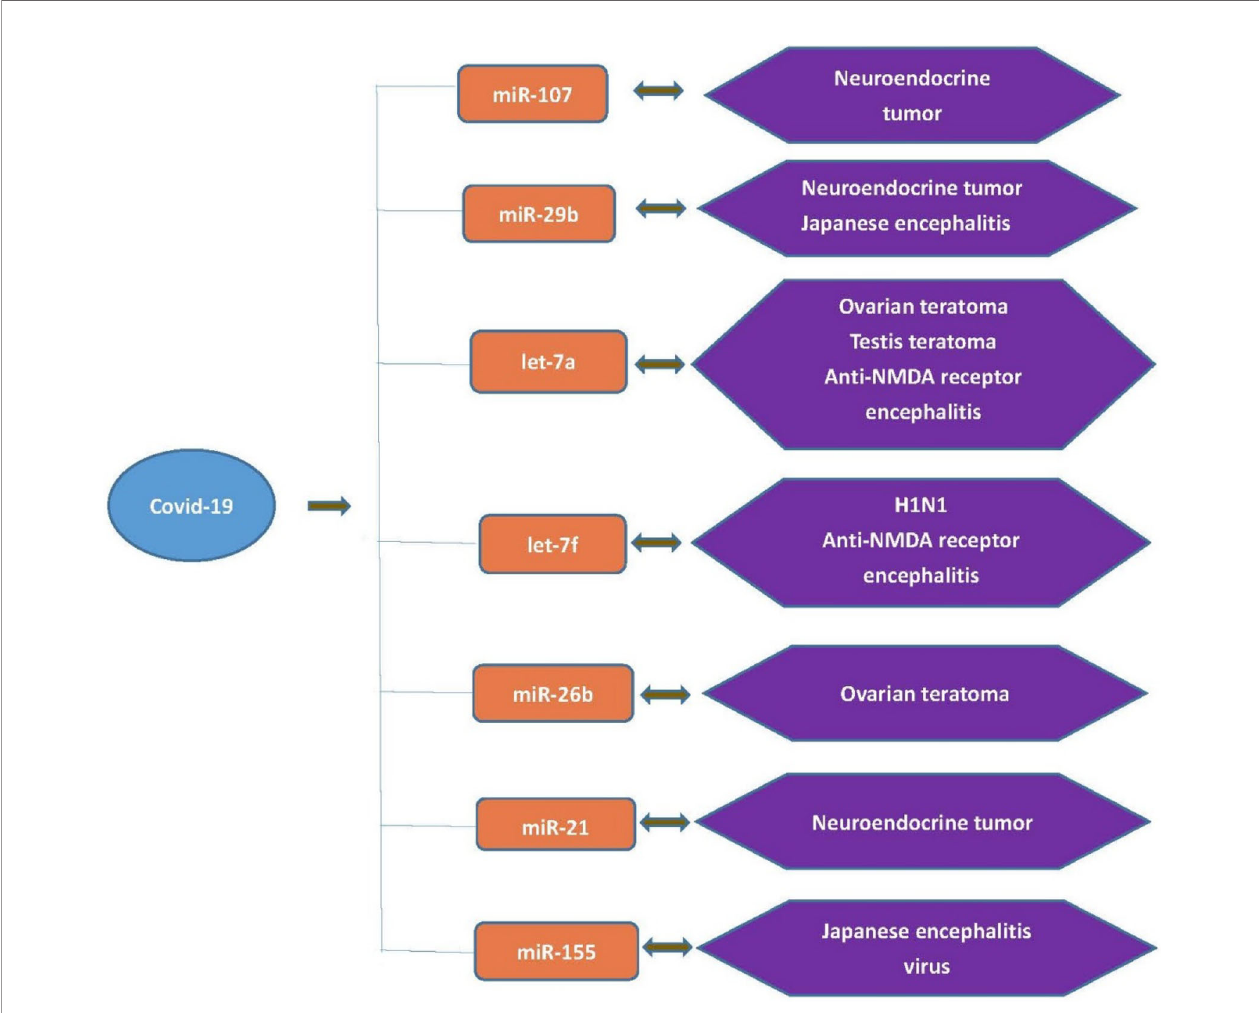
FIGURE 1 | Seven common miRNA biomarkers for COVID-19, anti-NMDA receptor encephalitis, tumors or vaccines related to anti-NMDA receptor encephalitis.